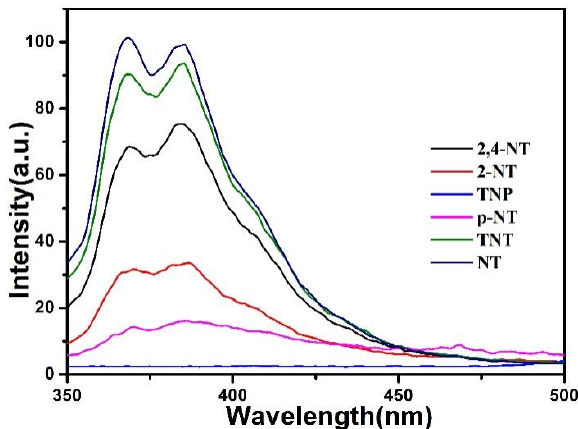
Figure 8. Fluorescence spectra of the compound towards explosives (1 × 10 − 3 M).